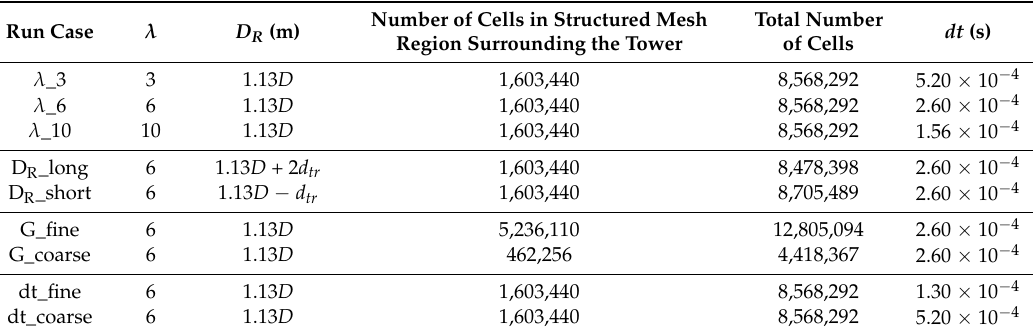
Table 1. Computational conditions. Here, λ is the tip-speed ratio; D R is the diameter of the rotational domain; D is the diameter of the rotor; d tr is the shortest distance between the tip of a blade and the edge of the rotational domain; and dt is the time-step